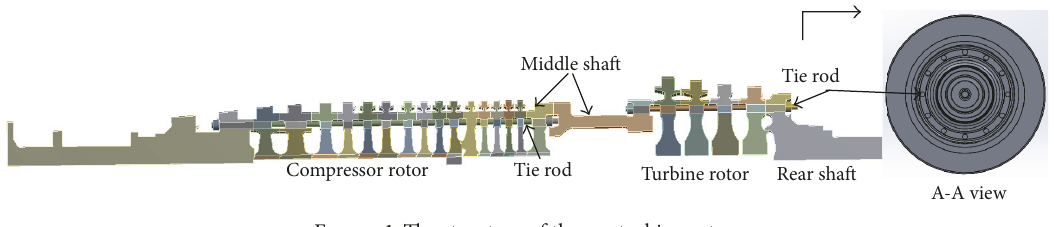
Figure 1: The structure of the gas turbine rotor.